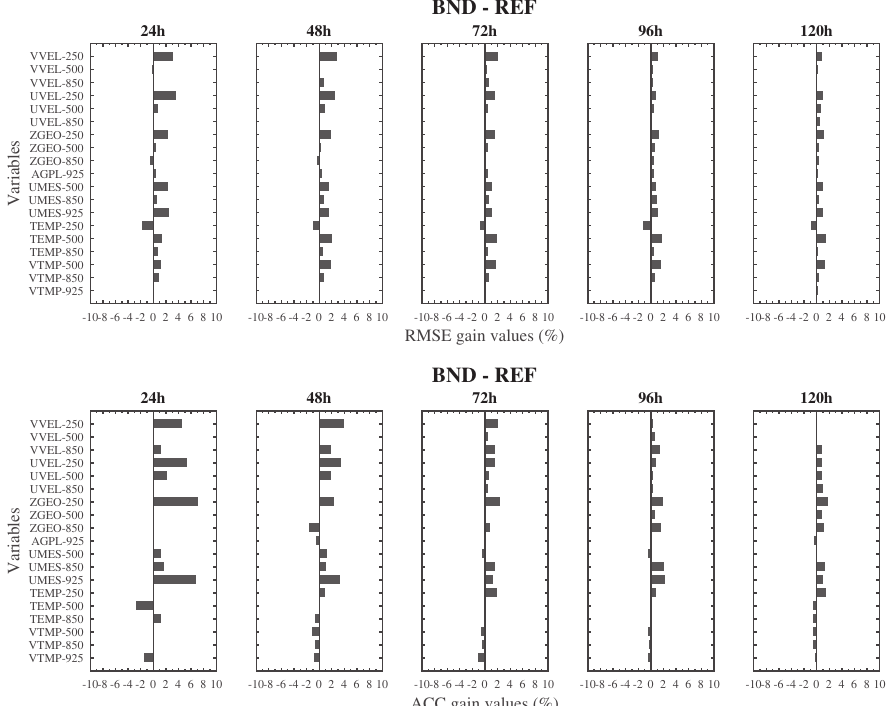
Figure 8. Differences in RMSE and ACC gain values for all variables (represented on the ordinate axis) for: 24-, 48-, 72-, 96- and 120-h forecasts (from left to right , respectively) over the global